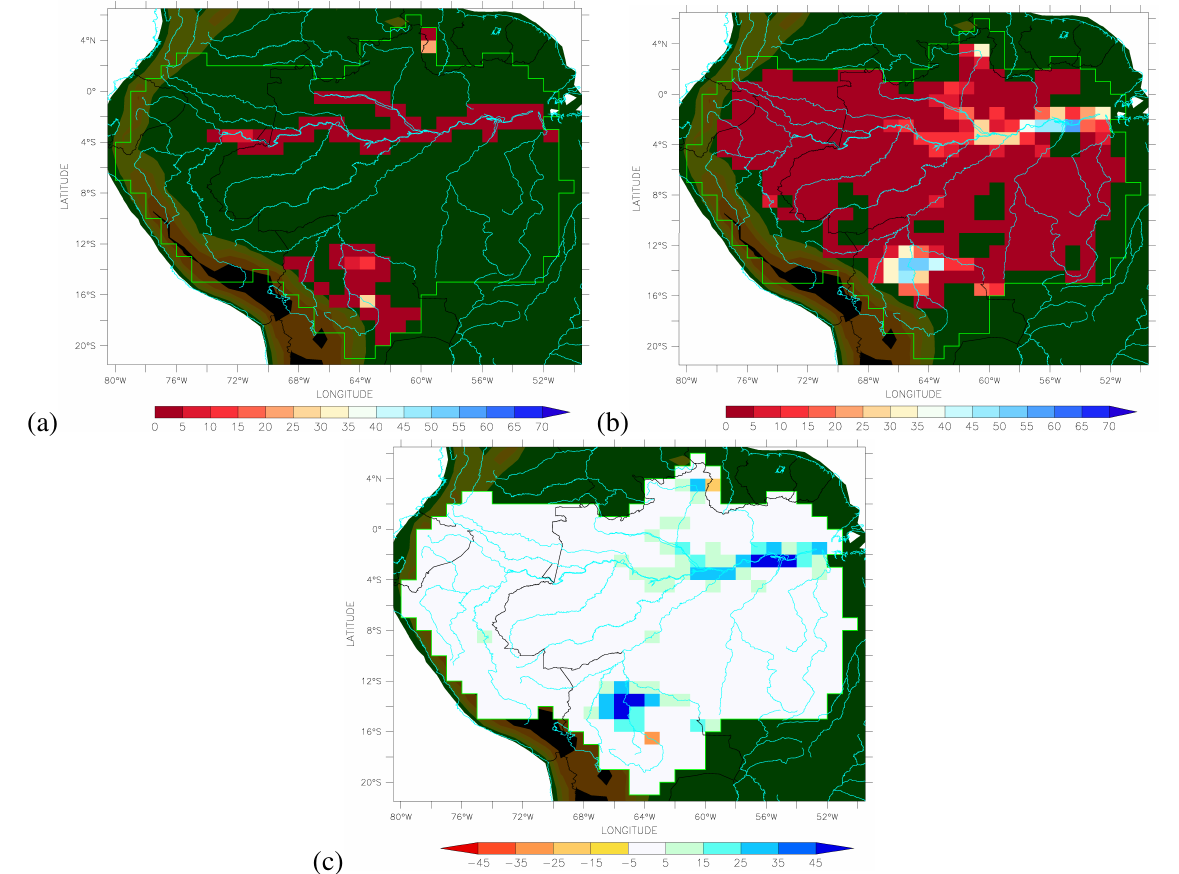
Fig. 4. Maximal fraction of floodplains within the mesh (% of the mesh area) over the Amazon River basin from (a) GLWD and (b) PRIMA. (c) Differences between (b) and (a) . Dark green and brown colors indicate the topography of the region. For topographic scale, see Fig. 2. Table 3. Proportions of maximal fractions of floodplains (MFF), swamps (MFS) and lakes (% of the areas of the basin) over the Amazon River basin according to GLWD and PRIMA